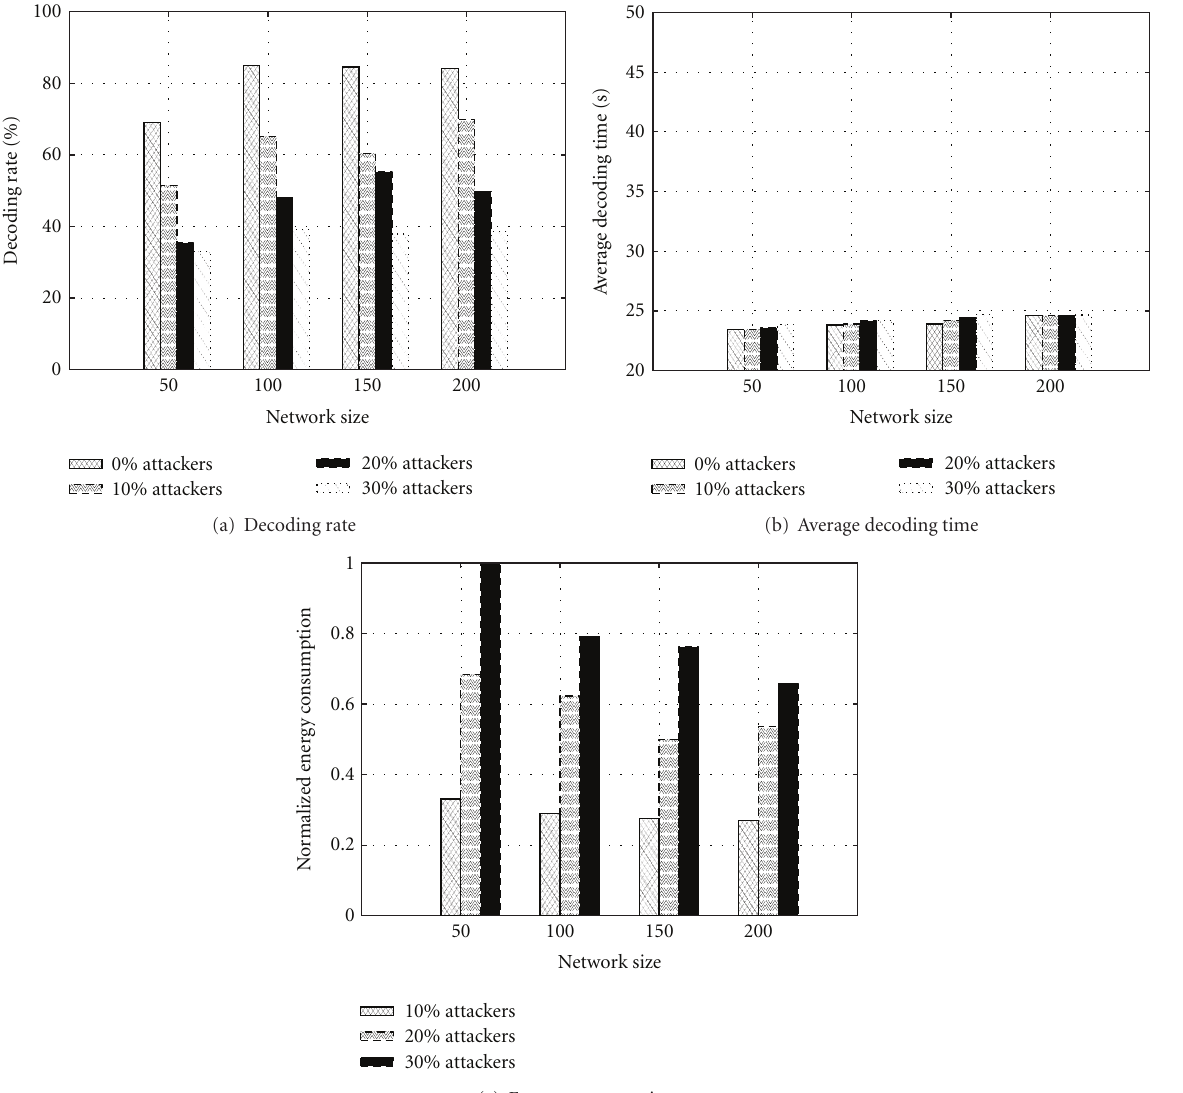
Figure 3: Performance results when multipath network coding is confronting to flooding